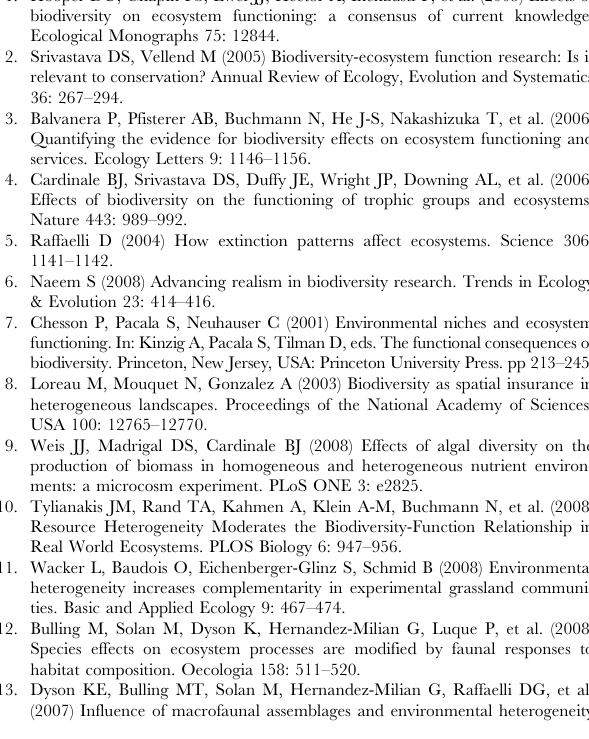
Figure S2 Van Krevelen diagrams of CHONS molecular compositions. Figure S3 Relationships of beta-diversity with diversity of DOC resource use and bulk DOC uptake. Figure S4 Alternative metavariable path diagrams calculated from Mantel statistics. Table S1 Characterization of the hydrodynamic conditions over the control streambed and the bedforms of the landscapes increasing in flow heterogeneity.